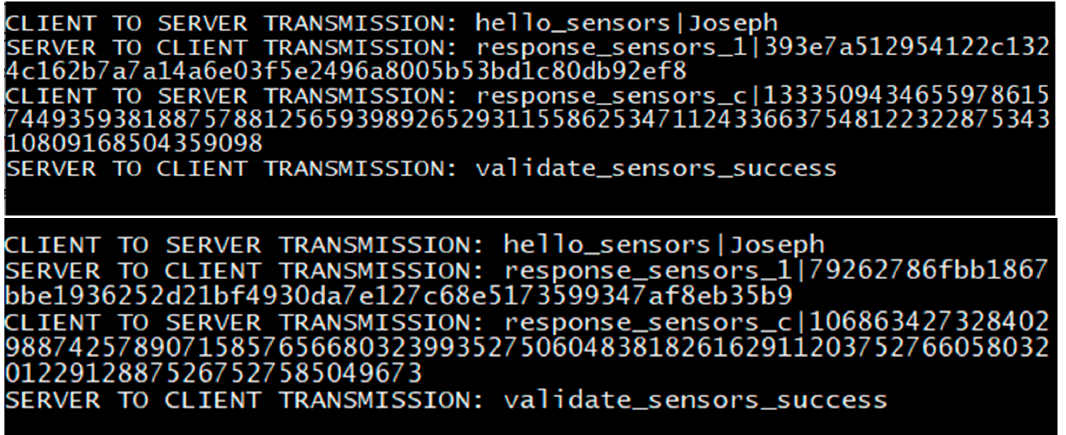
Figure 14. Intercepted data from client and server using the TFHVA scheme, between two different sessions.